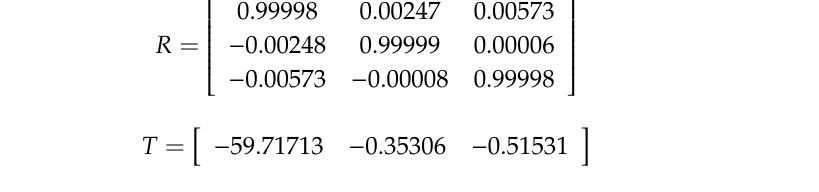
Figure 14. Results on the model M2. The loss changes during training as seen in Figures 15 and 16. It can be seen that the overall training process is convergent, but there is a phenomenon of a sharp increase in errors at a certain stage. This is because the difference between our data sets was large, and a certain part of the weight during the training process changes may lead to an increase in the segmentation accuracy of part of the image, but a sharp drop in another part of the image. The test result is shown in Figure 16 which represents accuracy, cross-entropy, and weight loss, respectively.